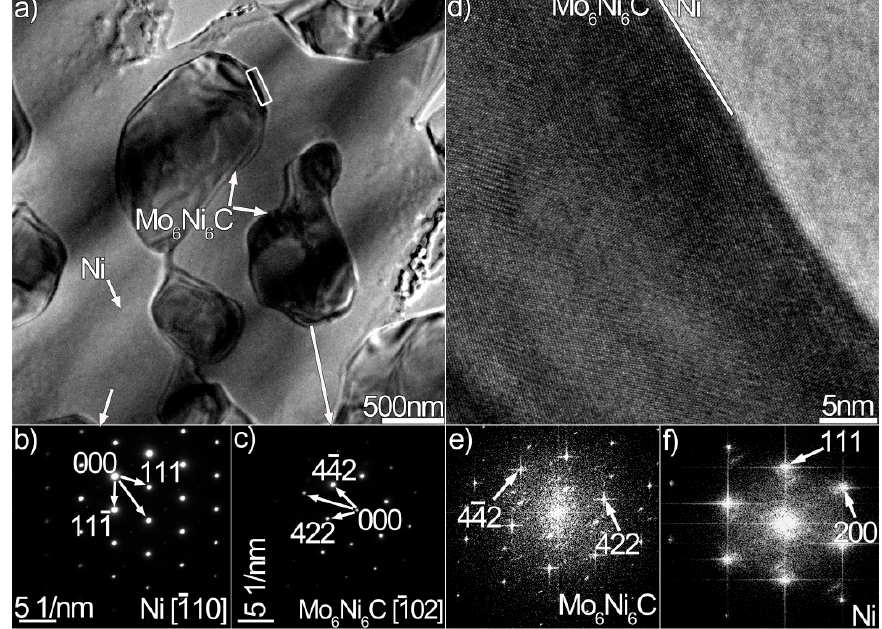
Figure 9. ( a ) Bright-field TEM micrograph of the coating aged for 480 h, ( b , c ) SAED patterns of the Ni and Mo 6 Ni 6 C in ( a ), ( d ) HRTEM image of the Mo 6 Ni 6 C / Ni interface enclosed in the white box in ( a ), and ( e , f ) FFT results of the Mo 6 Ni 6 C and Ni in ( d ).